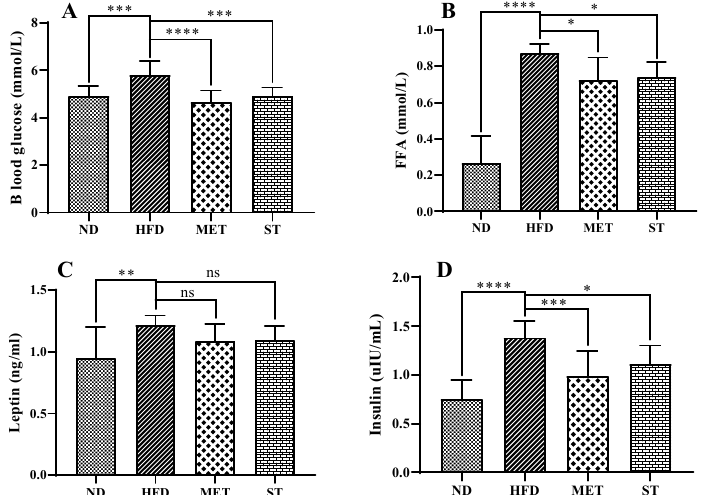
Figure 6. Effects of methanol extract of fermented green tea and spore suspension on diabetes related biomarkers in serum. ( A ): blood glucose; ( B ): FFA; ( C ): Leptin; ( D ): Insulin. Statistical significance of differences between groups was determined using Ordinary one-way ANOVA. Data are expressed as mean ± SD ( n = 10). * p ≤ 0.05; ** p ≤ 0.01; *** p ≤ 0.001 and **** p ≤ 0.0001. “ns” indicates not significant ( p > 0.05).